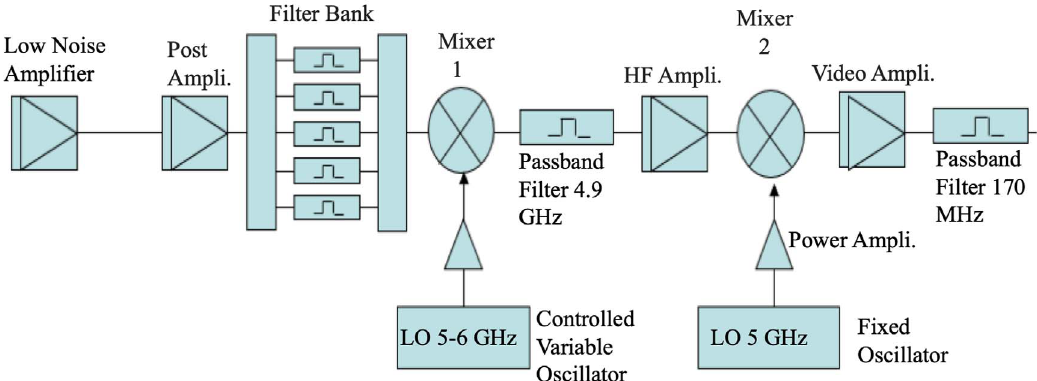
Fig. 2. Block diagram of the ORFEES receiver: superheterodyne